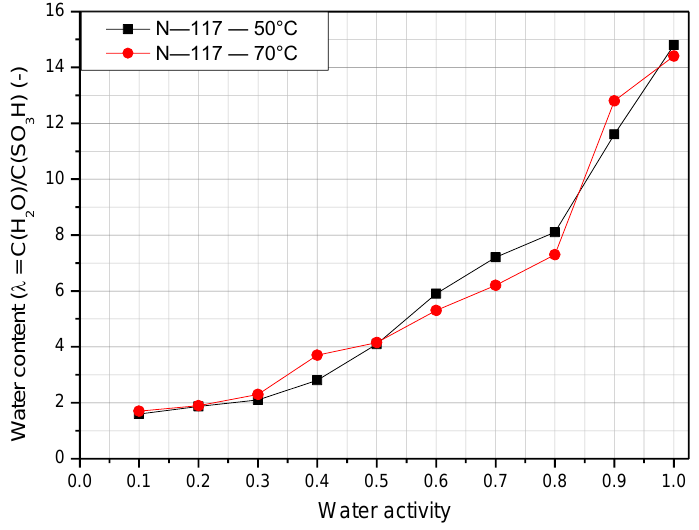
Figure 7. Water content of Nafion 117 membrane at operating temperatures of 50 °C and 70 °C.